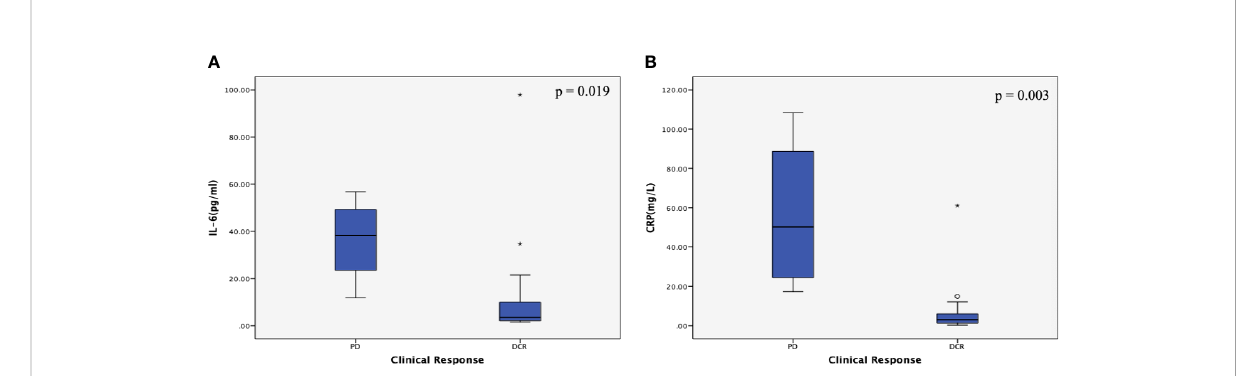
FIGURE 2 Correlations between in fl ammatory marker levels and the clinical response subgroup in patients with metastatic pancreatic cancer (mPC). (A) Correlation between interleukin (IL)-6 levels and the clinical response subgroup in patients with mPC. The serum IL-6 levels were higher in the PD group than in the DCR group (P = 0.019). (B) Correlation between C-reactive protein (CRP) levels and the clinical response subgroup in patients with mPC. The serum CRP levels were higher in the PD group than in the DCR group (P = 0.003). The P values were calculated using the Student ’ s t test. The symbol * means abnormal values in the